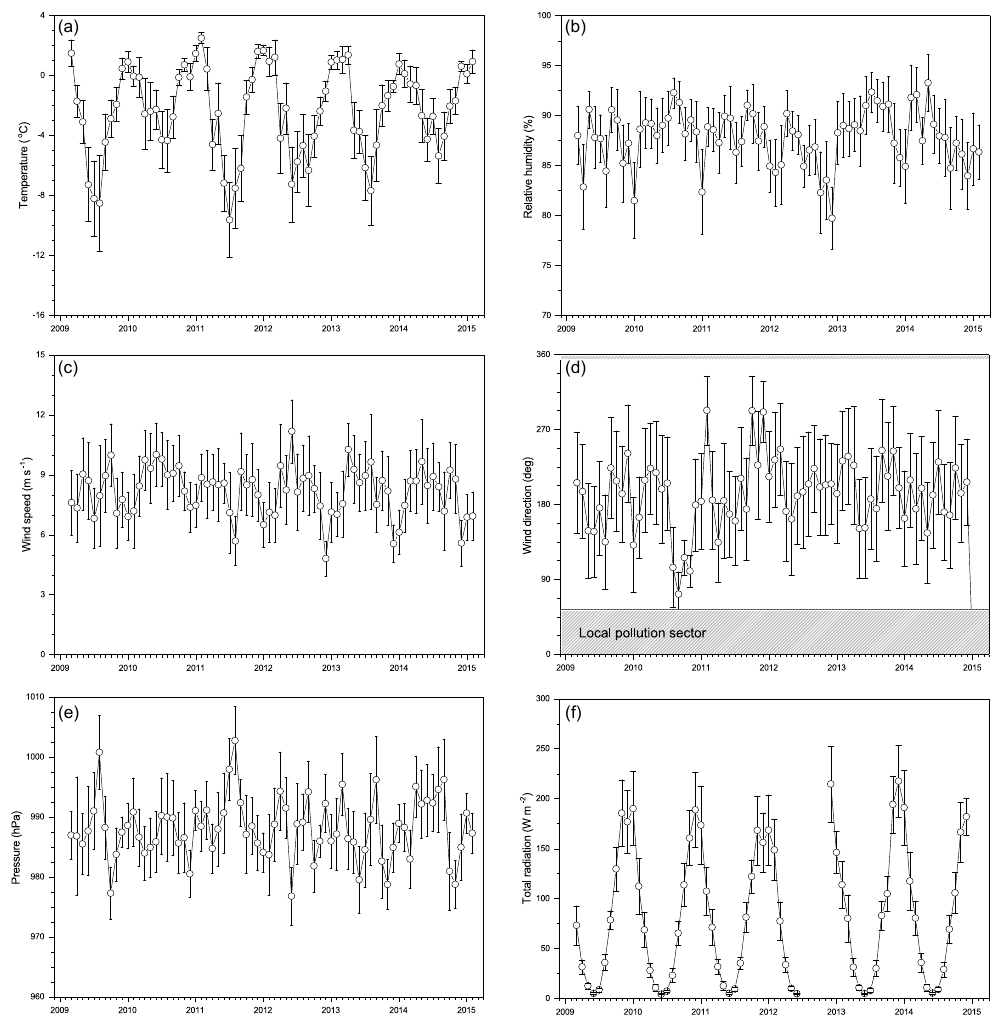
Figure 3. Monthly mean variation in (a) temperature, (b) relative humidity, (c) wind speed, (d) wind direction, (e) air pressure, and (f) solar radiation over the period from March 2009 to February 2015. The shaded area in panel (d) represents the wind direction for the local pollution